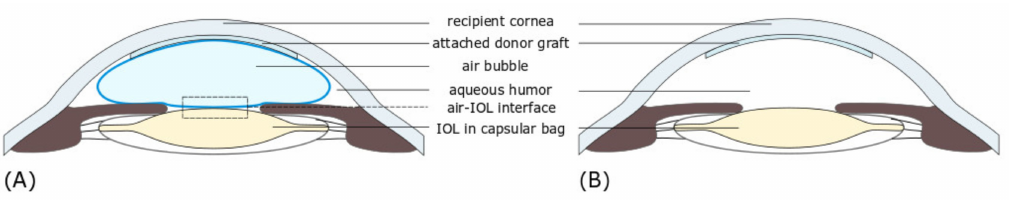
Figure 1. Schematic diagram of cross section through the anterior chamber of the eyeball after Descemet’s stripping endothelial keratoplasty (DSAEK), showing the location of corneal lamellar graft attached to posterior surface of the host cornea, an air bubble, and the intraocular lens (IOL) when the patient is laying face up. ( A ). The injected air fills 90 percent of the volume of the anterior chamber, supporting the graft. The area of contact between air and IOL (frame) corresponds to the area shown in Figure 1B. ( B ) After the air bubble has been absorbed, the anterior chamber is completely filled with aqueous